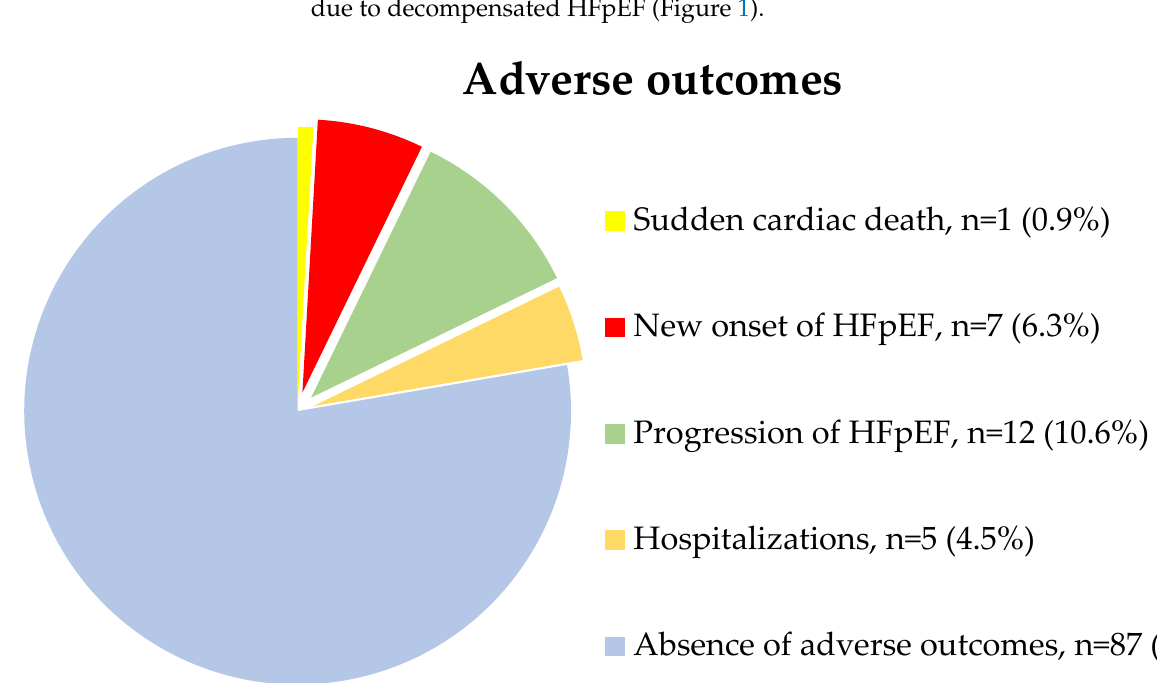
Figure 1. The adverse outcomes registered during 12 months of follow-up period. Based on Kaplan–Meier analysis, the rate of the adverse outcomes significantly ( p < 0.001) differed between groups (Figure 2). The incidence of adverse events pre- ponderated (45.2%, n = 19) in patients with CMD, than in patients without it (8.6%, n = 6).